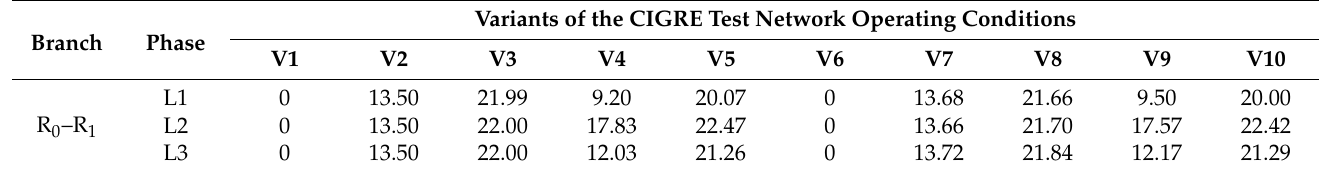
(%) in the CIGRE test network. R